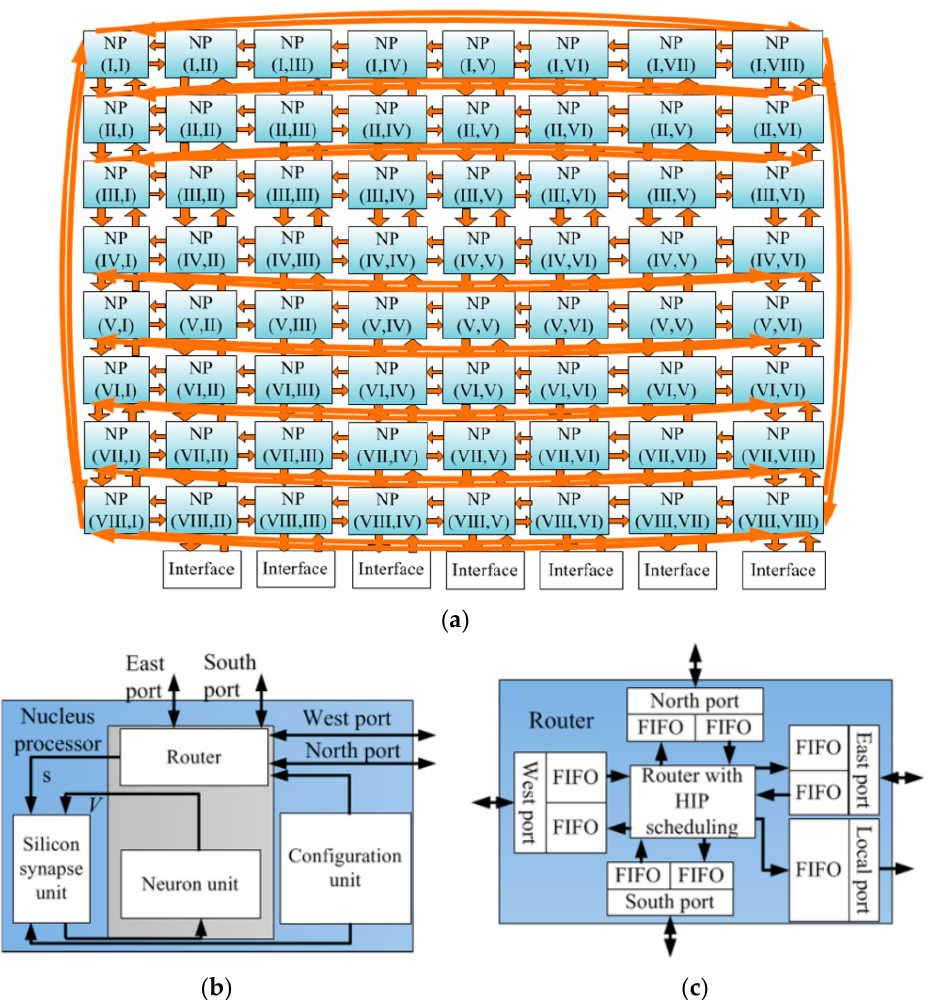
Figure 2. Digital implementation of the proposed hippocampal neural network. ( a ) Digital implementation of the network-on-chip (NoC) architecture; ( b ) Digital implementation of the nucleus processor (NP); ( c ) Digital implementation of the router.